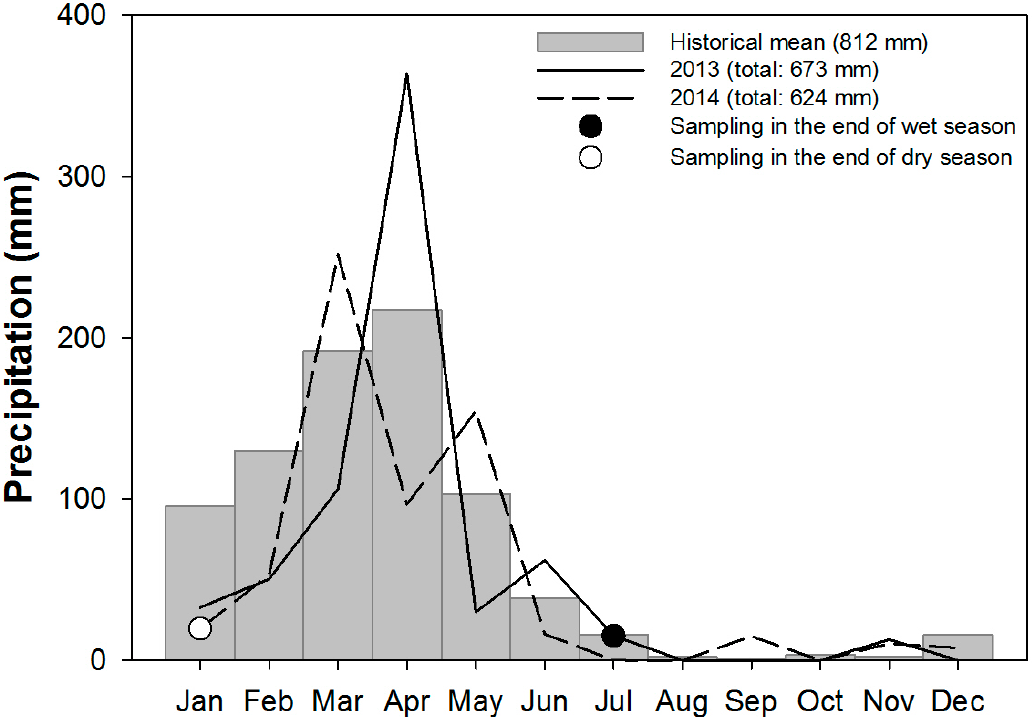
Figure 2. Mean annual precipitation (mm) for the studied mangrove forests, total precipitation for 2013 and 2014, and sampling dates (for soils and gas) at the end of both the wet and dry